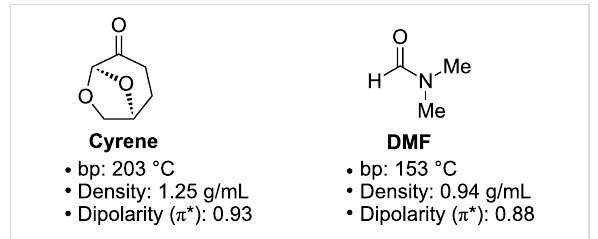
Figure 1: Cyrene vs. DMF – selected physical properties [31,32].